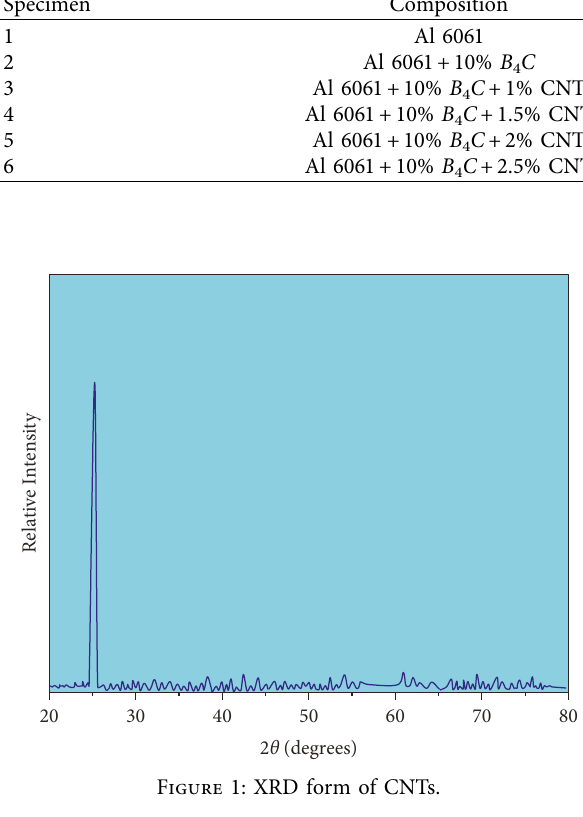
Figure 1: XRD form of CNTs.